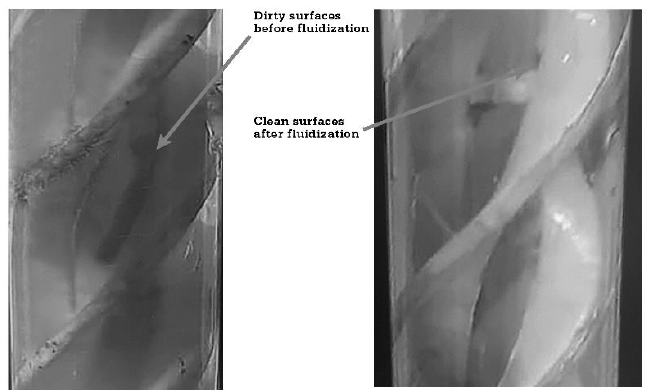
Figure 11. Cleaning effect of fluidized bed .